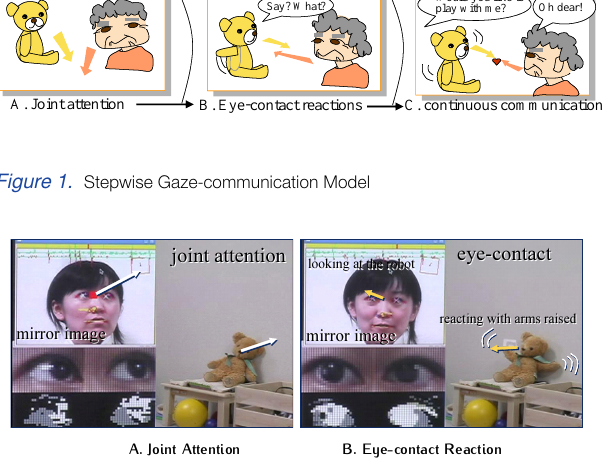
Figure 2. Examples of Gazing Behaviors of Stuffed-toy